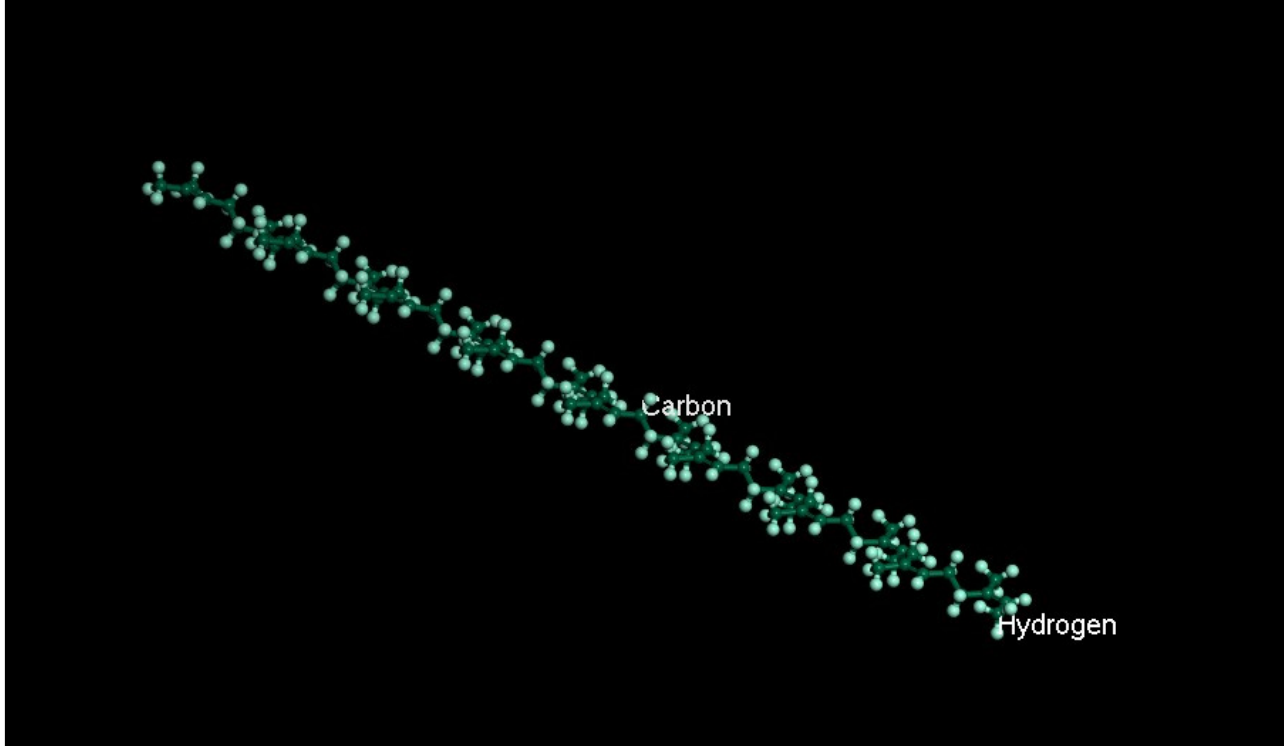
Figure 3. The molecular chain for NR.